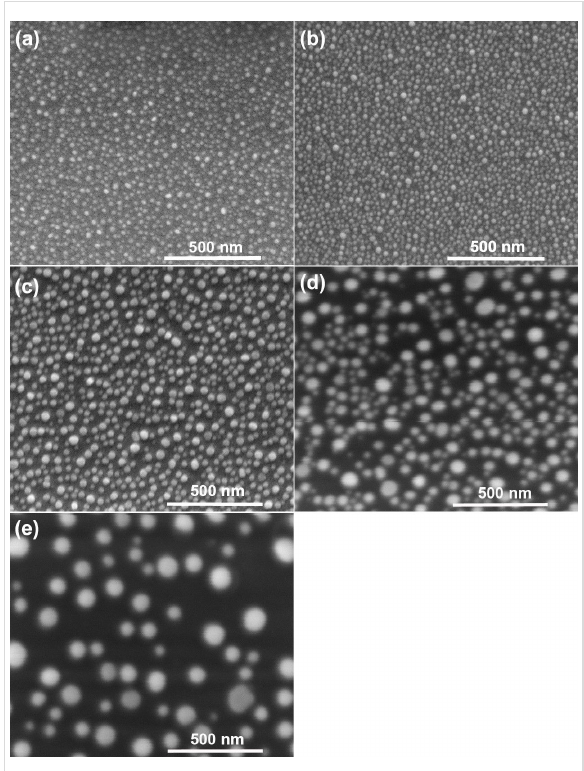
Figure 4: SEM images of Au films of different thicknesses on a Si(111) substrate annealed at 550 °C for 15 min: a) 1.7 nm, b) 2.8 nm, c) 3.1 nm d) 4.0 nm, e) 5.0 nm.